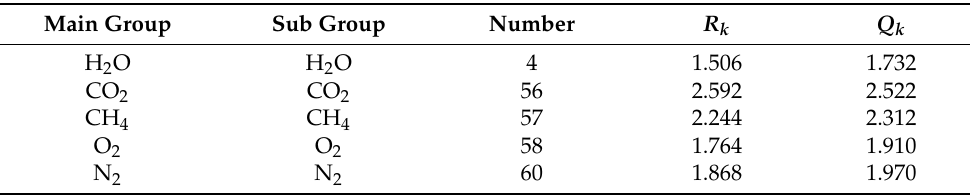
Table 1. The UNIFAC group volume and surface-area parameters.